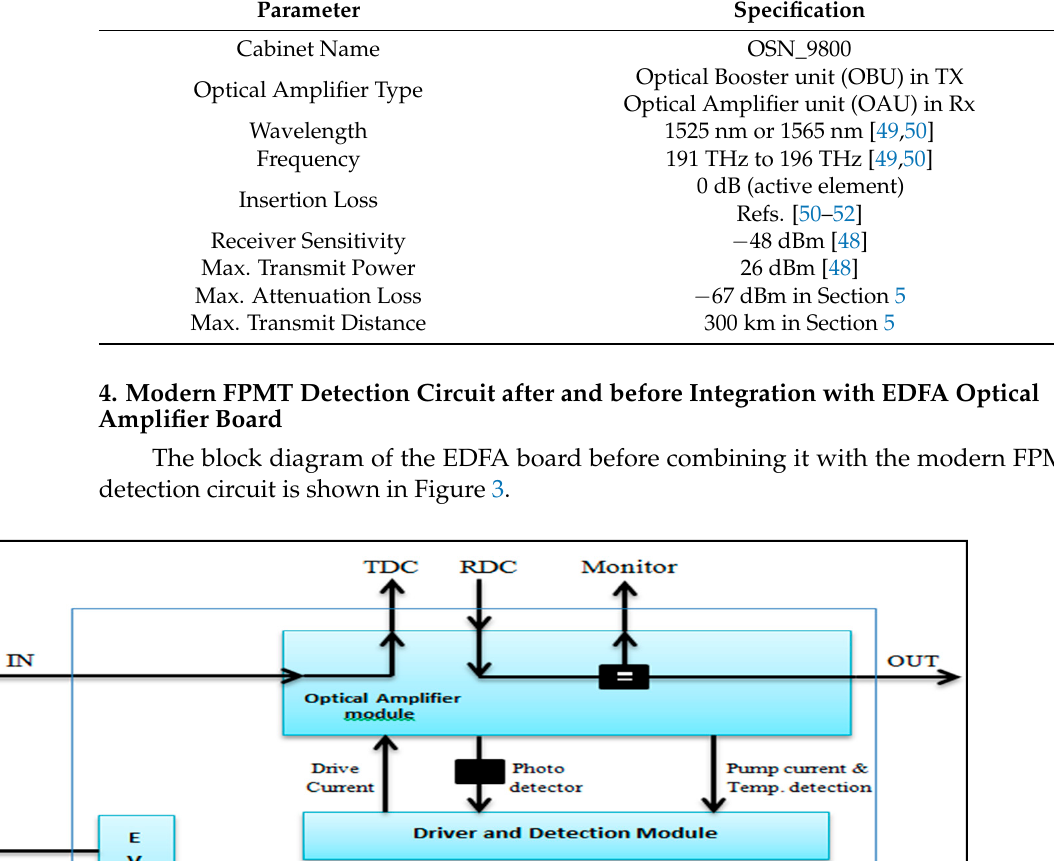
Table 3. The parameter of the EDFA optical amplifier board.